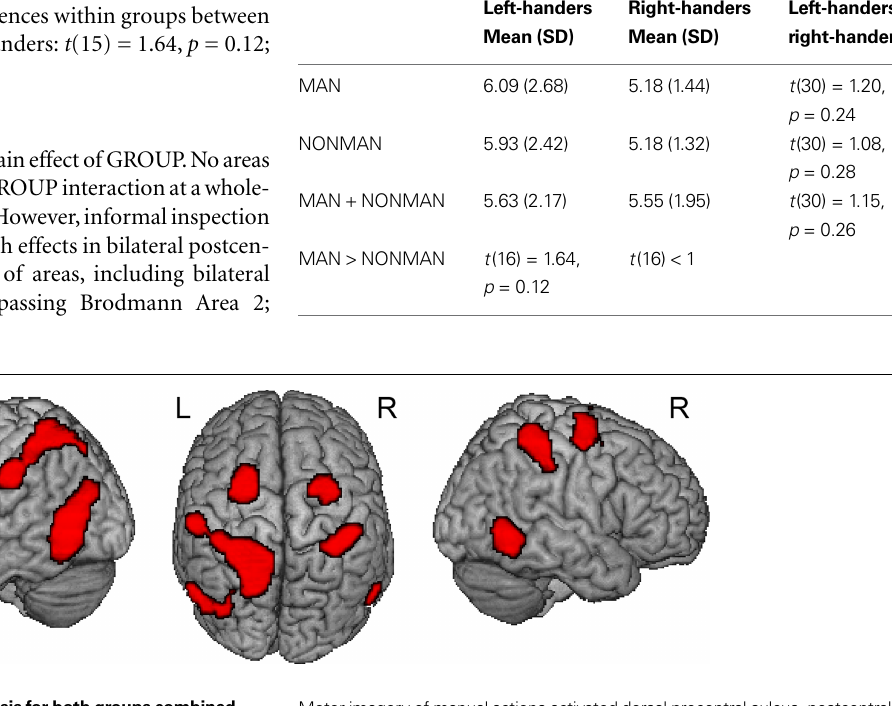
FIGURE 1 | Result from whole brain analysis for both groups combined. Motor imagery of manual actions activated dorsal precentral sulcus, postcentral Displayed are the results for comparing MAN > NONMAN across the two sulcus and inferior temporal sulcus bilaterally. Results are corrected for multiple + MAN > NONMAN + NONMAN groups (MAN ). comparisons at p < 0.05 corrected. left-handers right-handers left-handers right-handers